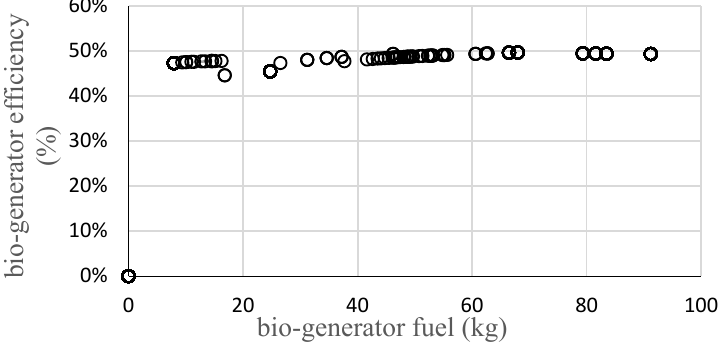
Figure 9. Biomass system efficiency (%) with respect to fuel mass (kg).